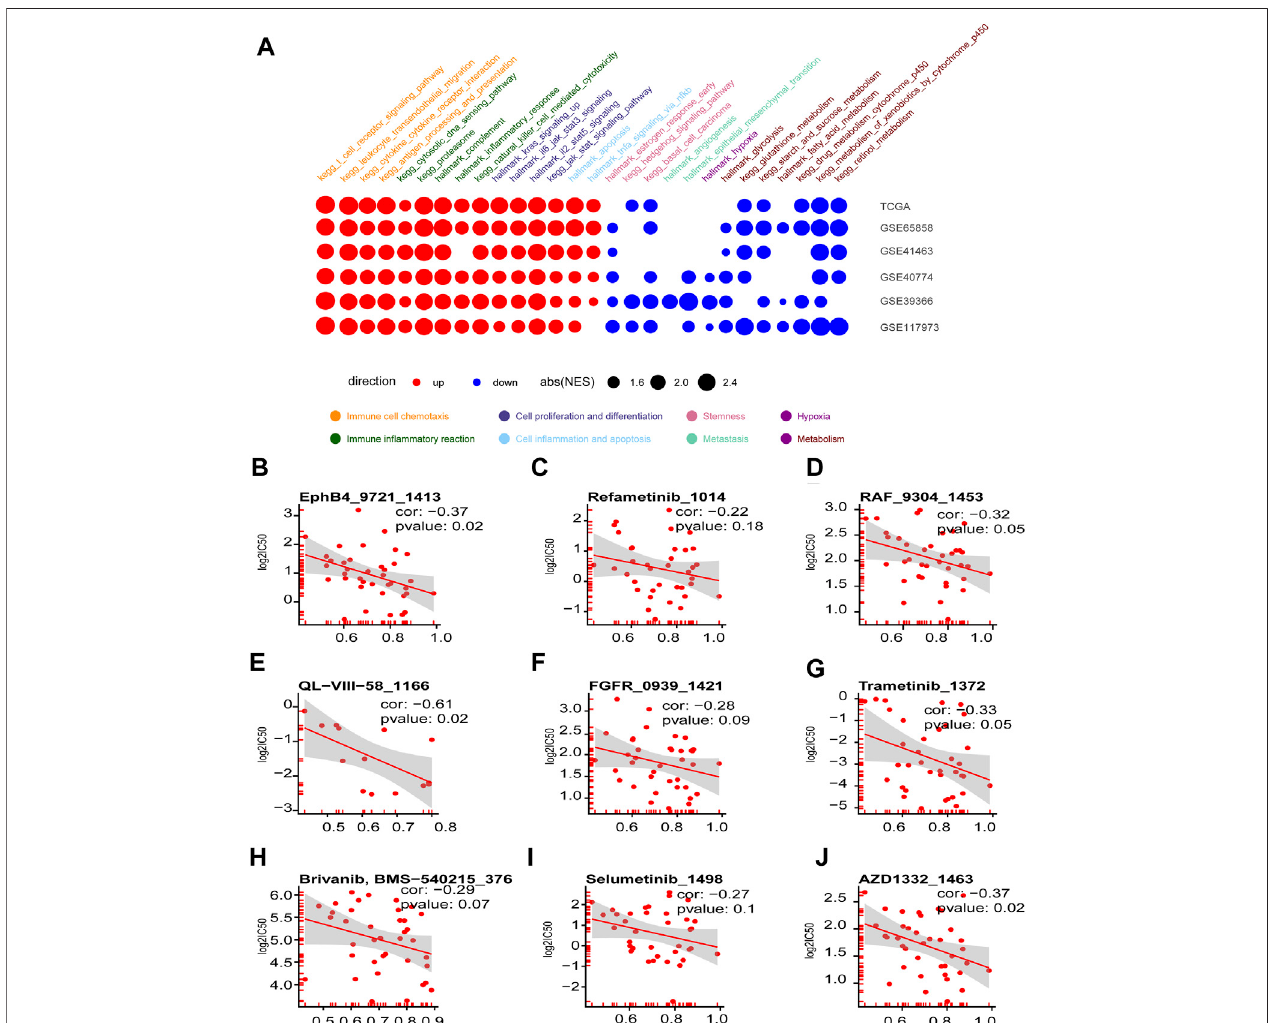
FIGURE7| Enrichedtumorigenesispathwaysinimmunehotandcoldphenotypesdeterminedbythefourchemokines(CXCL9,10,11,andCCL5)andimmunehot sensitivedrugs. (A) DotplotsummarizedtheGSEANESscoresofsignalpathwaysrelatedtotumorimmunityandtumorigenesisbetweenimmunehotandcoldgroupsin the six HNSCC cohorts (only p .adjust < 0.05 were given). (B – J) Scatter diagram summarized the correlation coef fi cients between GSVA score of CXCL9, CXCL10, CXCL11, and CCL5, and the log 2 (IC50) in seven drugs targeting ERK-MAPK pathway (B – I) and two drugs targeting RAS pathway (I, J)